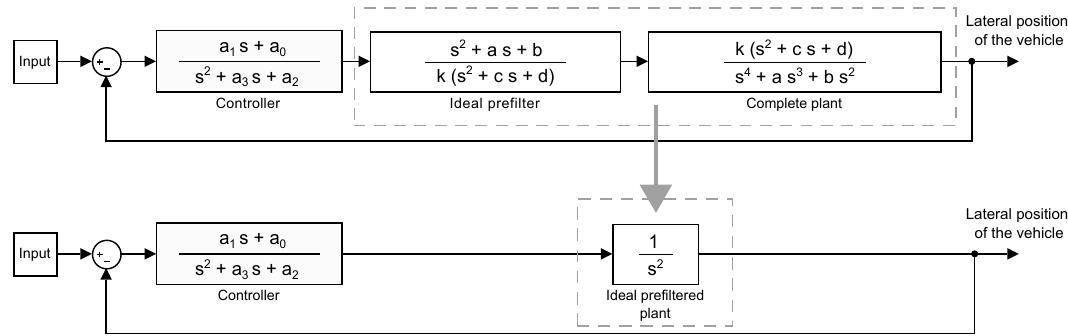
Figure 14. Equivalence of a perfectly prefiltered system.